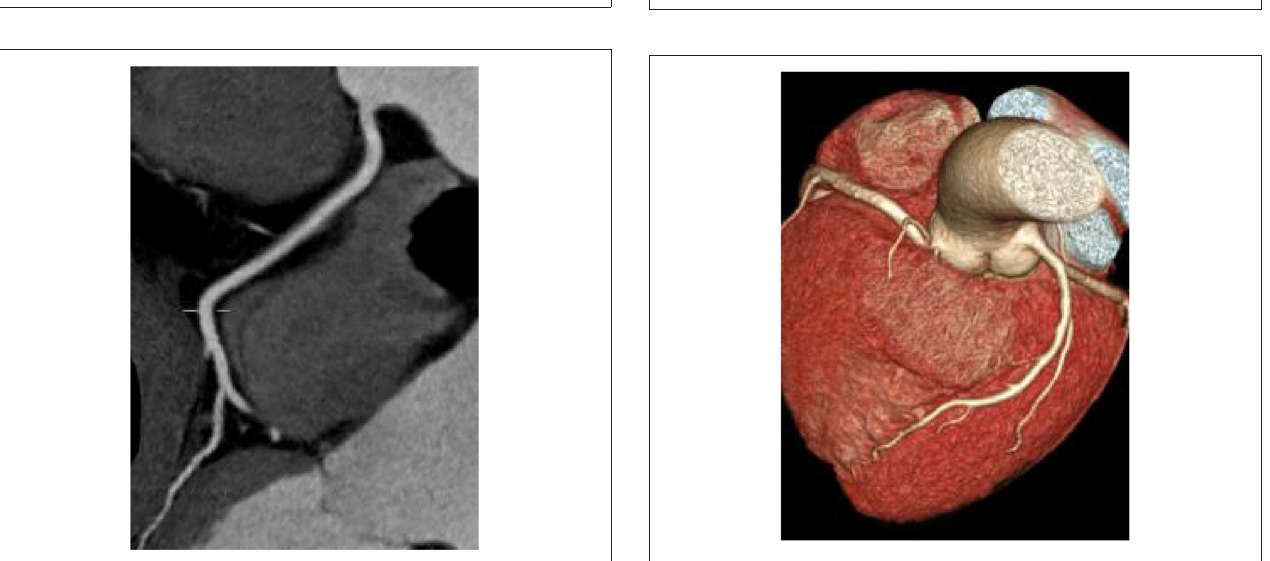
FIGURE 3 | Typical image of coronary CT angiography (CCTA) volume rendering in the control group.